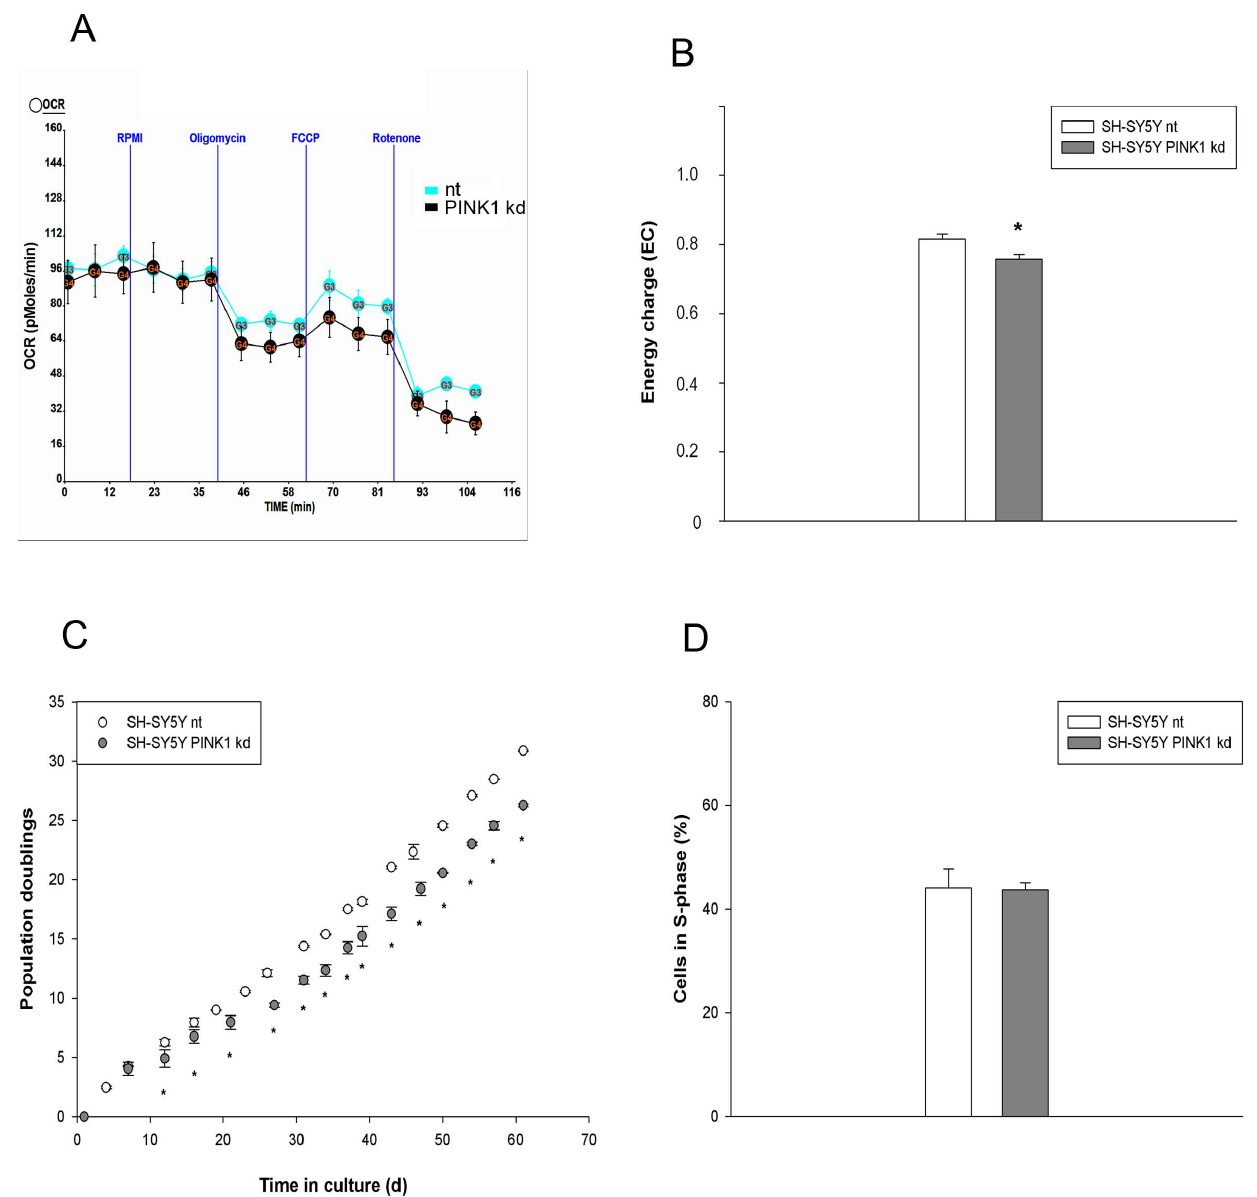
Figure 4. Reduced PINK1 levels influence cell metabolism and population growth. 4A) Oxygen consumption rate (OCR) was measured in nt and PINK1 knockdown (kd) SH-SY5Y cells without (nt) or with PINK1 knockdown (kd) cultivated in RPMI medium with 5% FCS. Although oxygen consumption appeared to be slightly impaired in cells with PINK1 kd, no significant changes were observed; n=1 (quadruplicates). 4B) Energy charge (EC) of nt and PINK1 knockdown (kd) SH-SY5Y cells grown in RPMI + 5% FCS was determined as detailed in Material & Methods. PINK1 knockdown resulted in a lower EC compared to nt cells; n=5, p , 0.05. 4C) nt and PINK1 knockdown (kd) SH-SY5Y cells were grown for 2 months in RPMI + 5% FCS and their population doublings were determined. Starting from day 12 cells with PINK1 kd exhibited impaired cell population growth; n=1 (triplicates); * p , 0.05 (day 12) - p , 1 6 10 2 6 (day 61). 4D) SH-SY5Y cells were grown in RPMI + 5% FCS and the amount of nt and PINK1 knockdown (kd) cells in S-phase was determined by BrdU incorporation. No differences in cell proliferation were visible between cells without (nt) and with PINK1